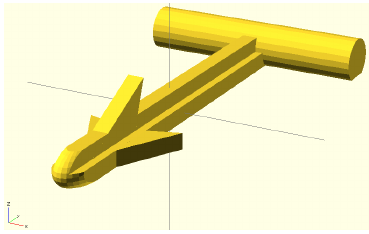
Figure 13. Tool for gutting an animal.